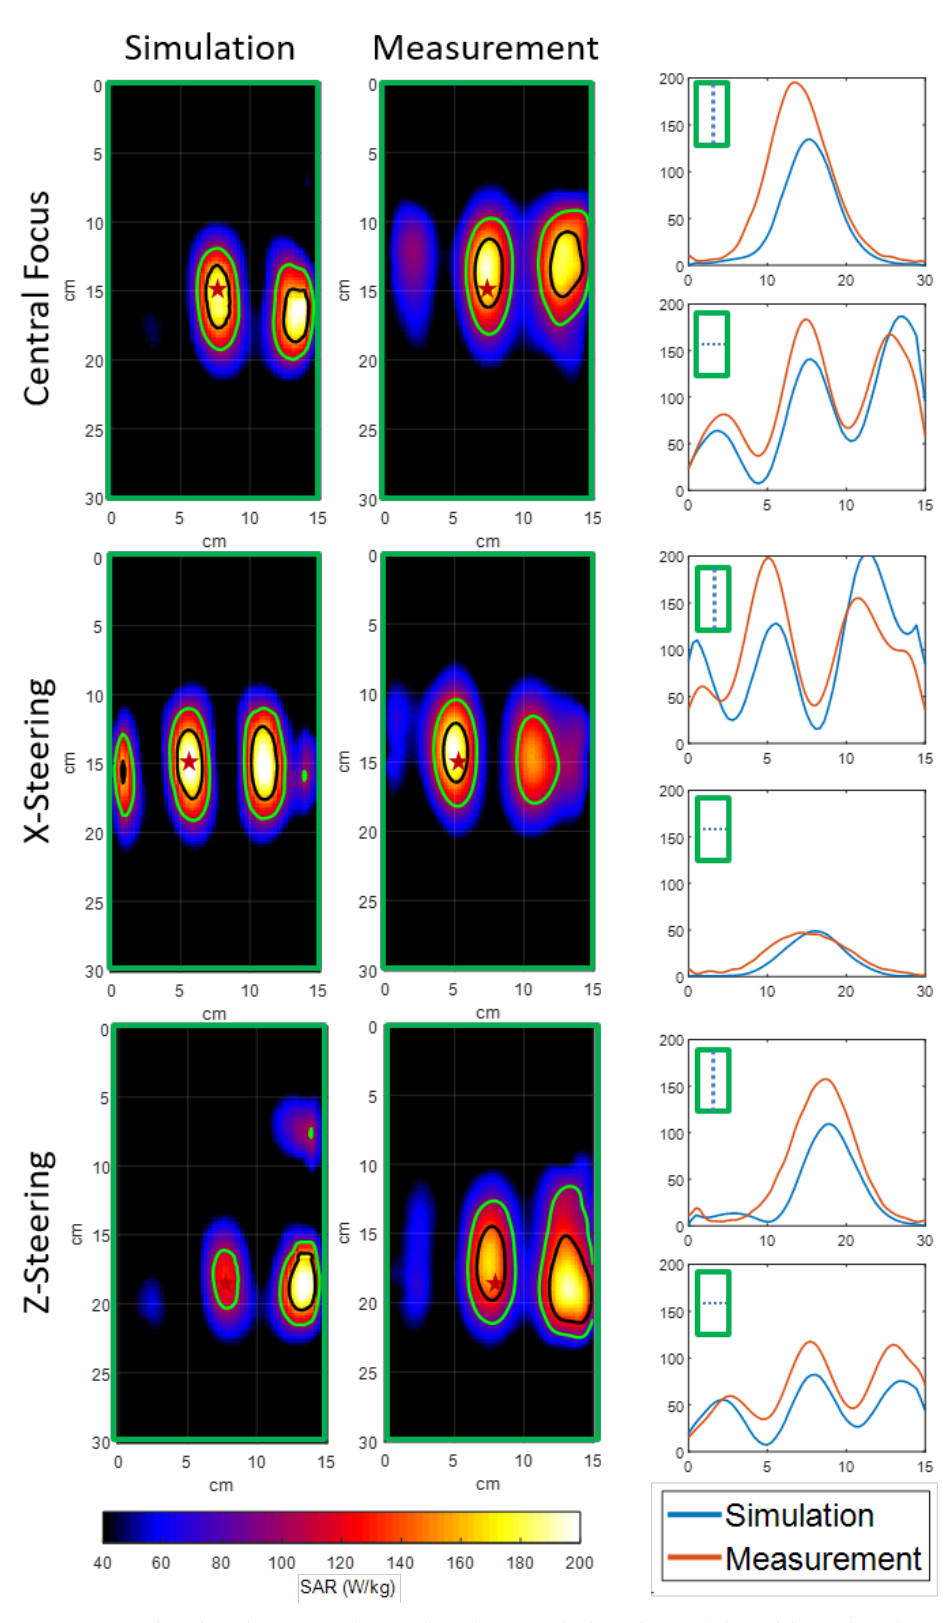
Figure 4. Simulated and measured SAR distributions ( left and middle ) and line plot along the phantom’s vertical and the horizontal axis. The green border shows the phantom outline and the red star shows the approximated focus point: central ( top ), x = +2 cm ( middle ) and z = +4 cm ( bottom